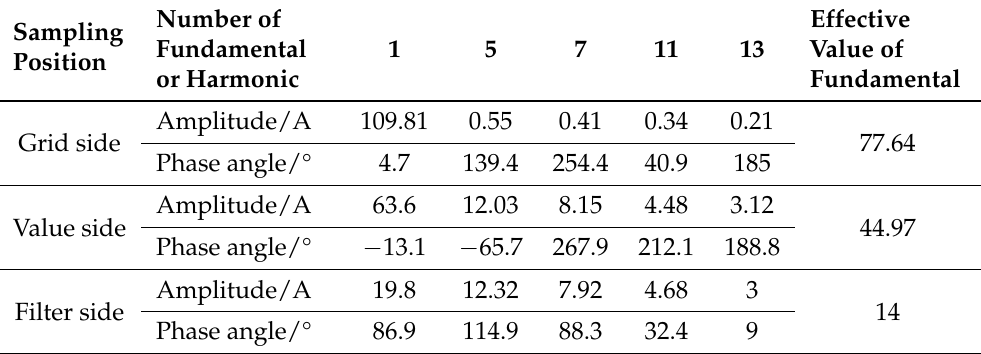
Table 3. Current values from each winding at phase A under the rated operation of the inductive filter converter transformer with the YYD structure.